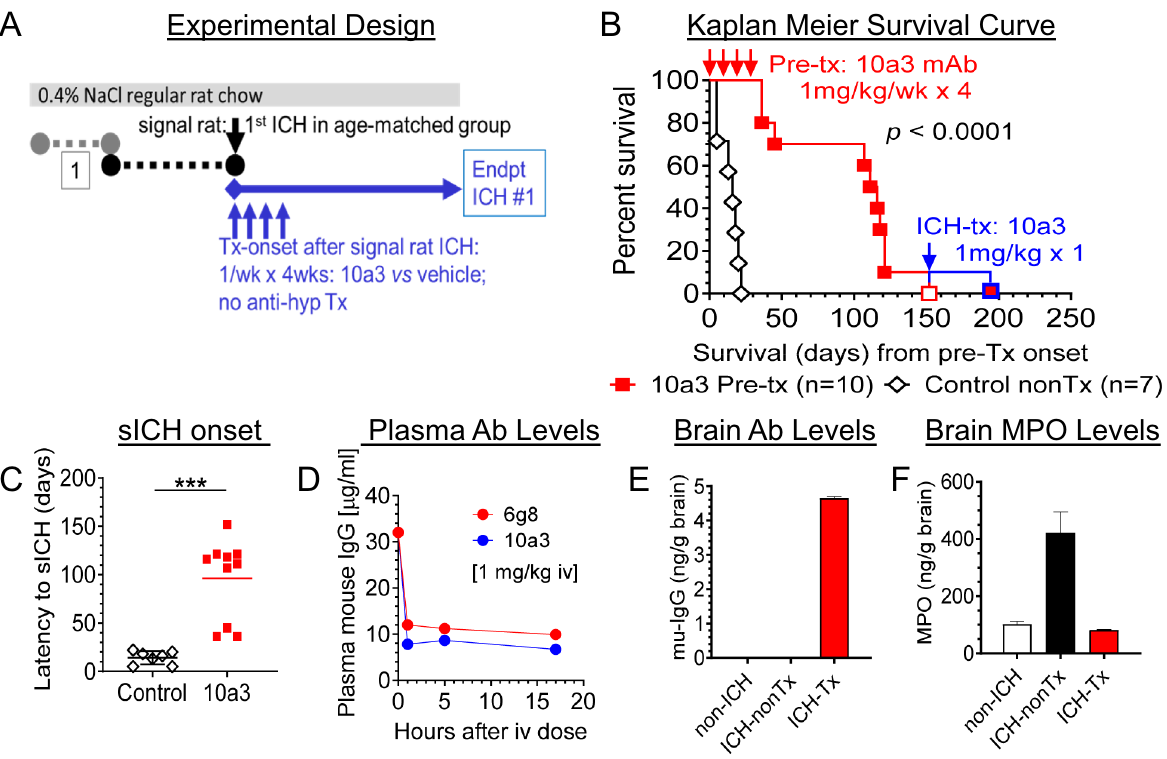
Figure 4. Preclinical testing for potential infection-risk or adverse events using multi-dose anti-DEspR mAb prototype, 10a3, in imminent pre-ICH stage. ( A ) Diagram of experimental design: monitor for 1st sICH-event identifying “signal” rat and onset of imminent pre-sICH stage in age-matched cohort, randomize to treatment or vehicle-control group; start 10a3-treatment: 1 mg/kg/dose iv/week × 4 weeks; daily monitoring; no anti- hypertensive meds. ( B ) Kaplan–Meier curve analysis to onset of 1st stroke comparing controls (n = 7) and age-matched 10a3-treated (n = 10) hsICH female rats: significant differences in time to 1st sICH, Mantel-Cox log rank test p < 0.0001 with log rank hazard ratio (95% CI) 5.46 (1.2–24.4). ( C ) Comparison of sICH-onset from day of signal rat stroke between treated and controls: two tailed, unpaired Mann Whitney rank test: ***p = 0.0001. ( D ) Analysis of plasma levels of single-dose anti-DEspR murine prototype 10a3 mAb and 6g8 mAb (murine precursor for humanized anti-DEspR) in imminent pre-hsICH rats (n = 2 rats/group), each at 1 mg/kg/dose iv. ( E ) Brain target engagement: mouse-specific IgG levels in brain membrane bound proteins (mu-IgG ng/ gram brain) of 6g8 in pre-hsICH rat brain (ICH-Tx) compared with control non-sICH